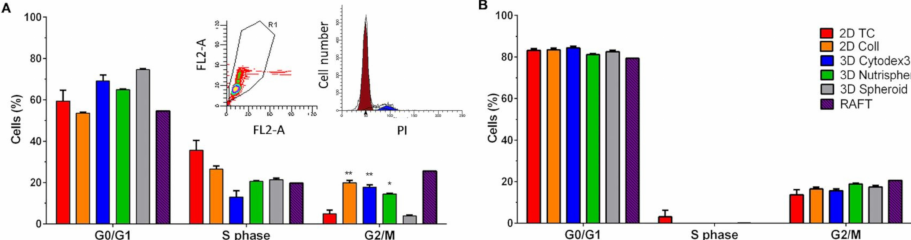
Figure 3. Cell cycle phase distribution of A549 cells cultured under di ff erent conditions at the 4 th ( A ) and the 9 th culturing days ( B ). Insert shows PI signal of single cells FL2-A (area)-FL2-W (width) gating out aggregates ( A left insert) and a representative image of cell cycle phases ( A right insert). Data are mean ± SD of three replicates except RAFT where 12 collagen discoids were